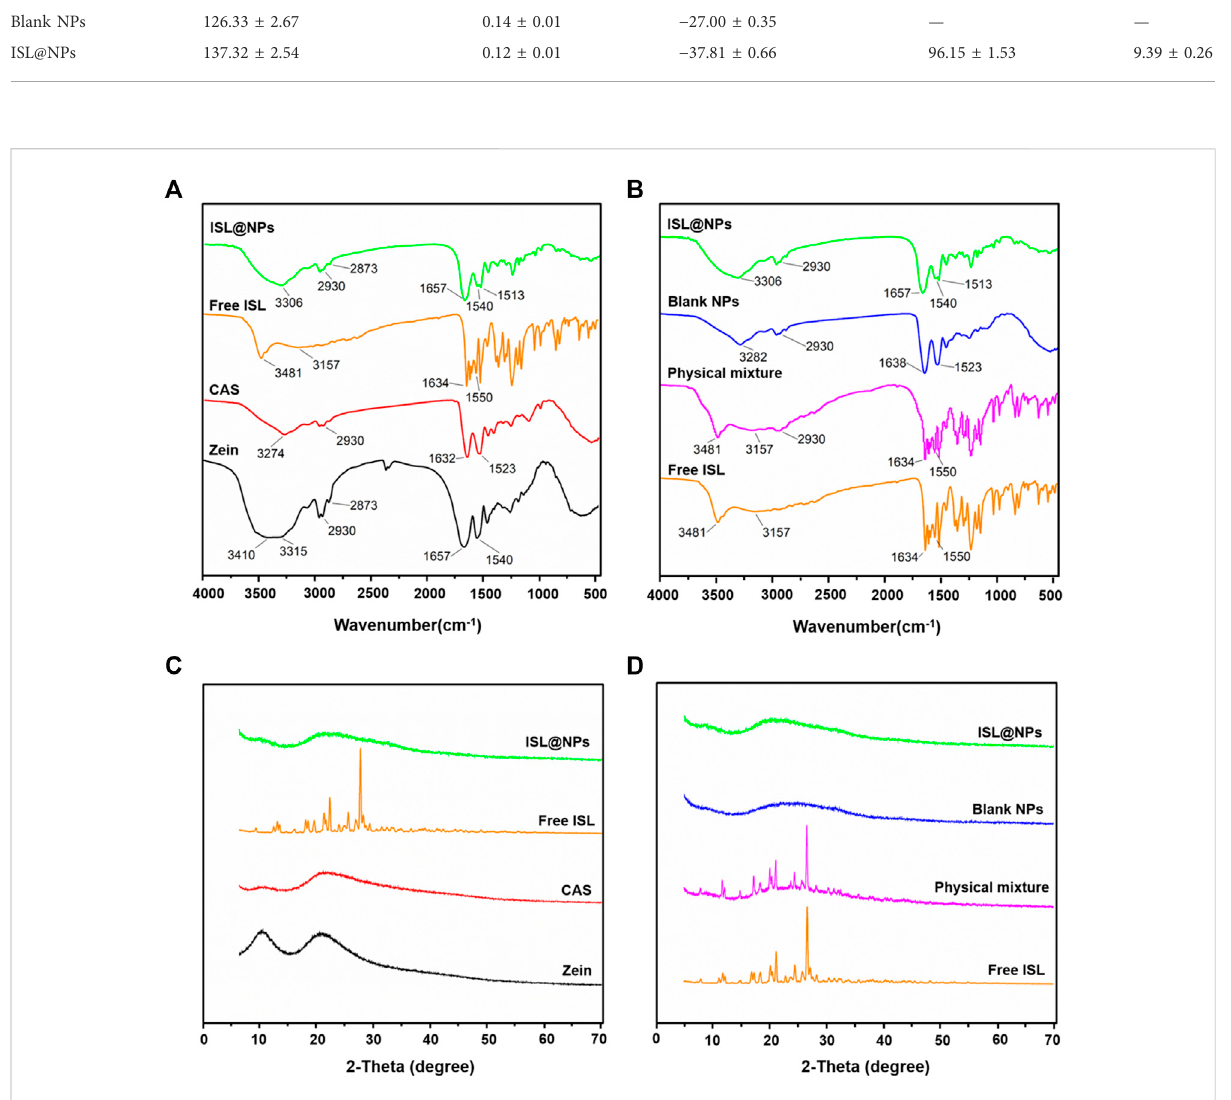
FIGURE 2 FT-IR (A-B) and XRD (C-D) were implemented to characterize